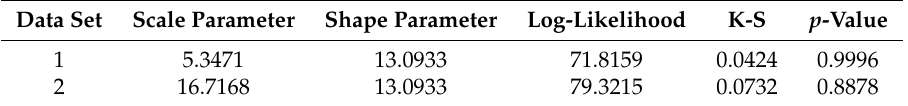
Table 10. Scale parameter, shape parameter, log-likelihood, K-S distances and p -values of the fitted inverse Weibull models to Data Sets 1 and 2. Here, we assume that the two shape parameters are